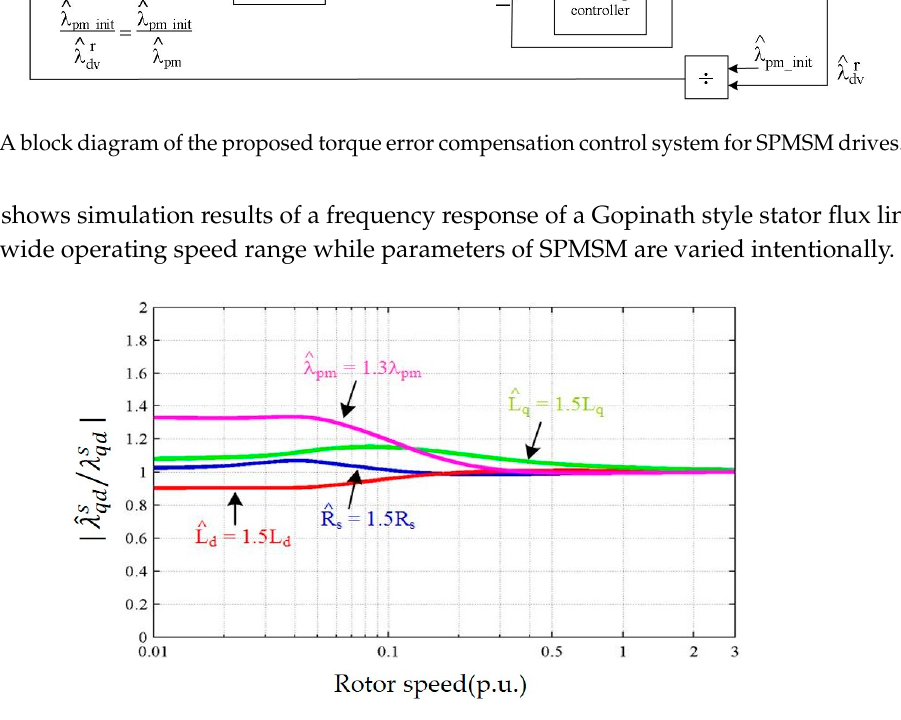
Figure 4. Simulation results of a frequency response of the Gopinath style stator flux linkage observer with respect to motor parameter variations.